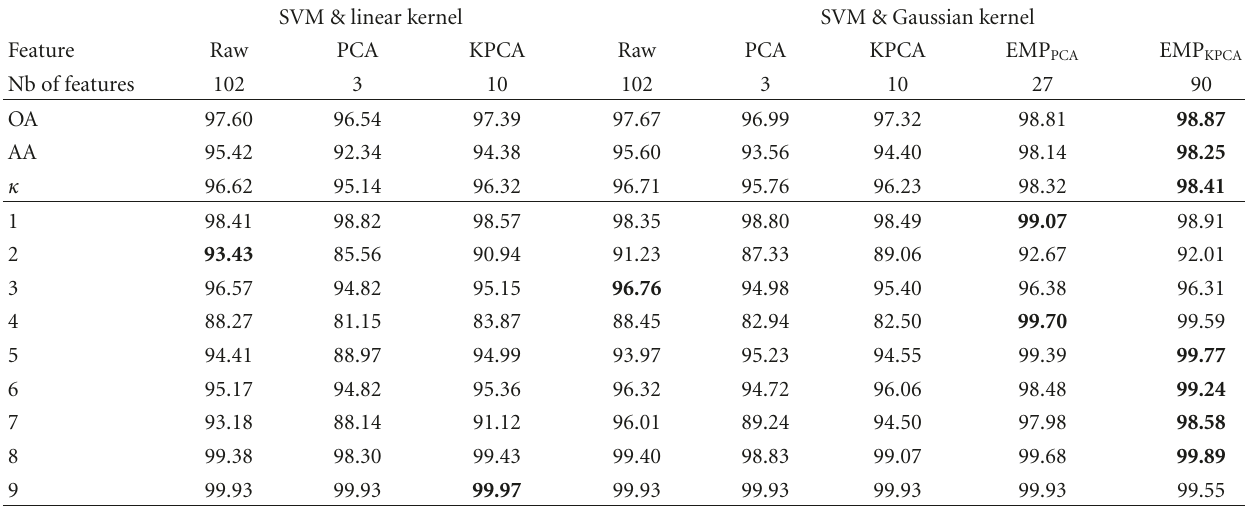
Table 8: Classification results for the Pavia Center data set. SVM & linear kernel SVM & Gaussian kernel